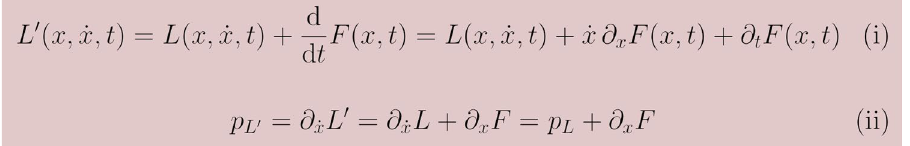
Figure 1. Change of conjugate momentum under an equivalent transformation of the Lagrangian L defined by F , a function of the generalized coordinates and